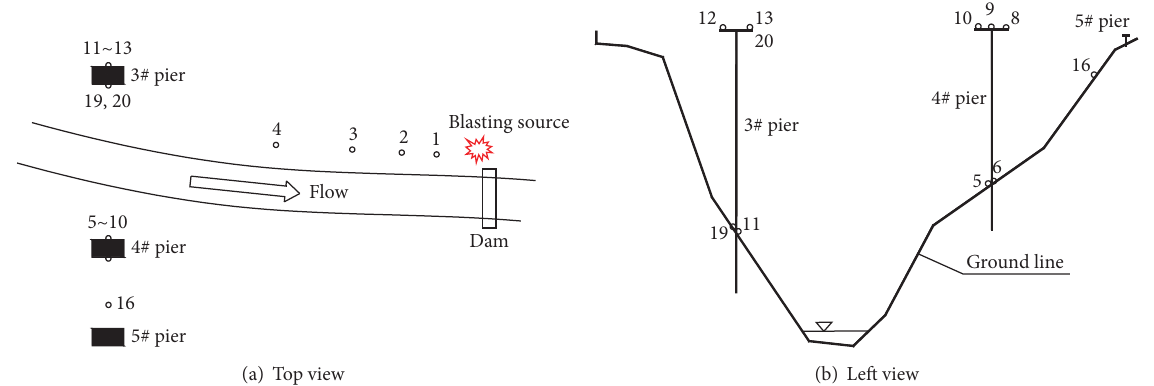
Figure 5: Monitoring points in the blasting test at left abutment.